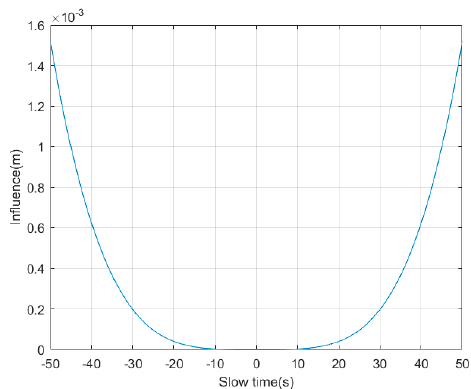
k of slant range. Figure A2. The influence of target motion on k 4 MT of slant 4 MT